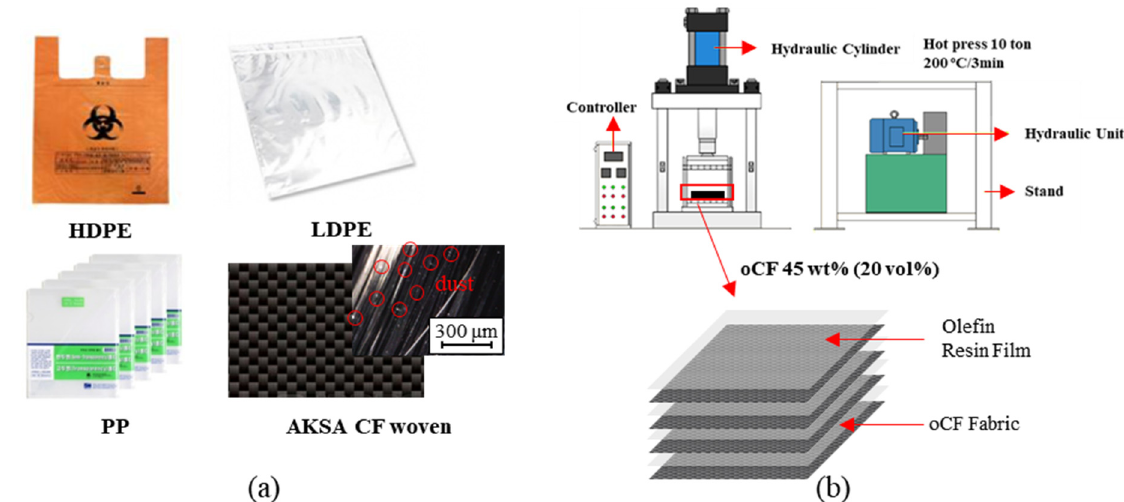
Figure 1. Experimental materials of ( a ) film-type olefin resins (HDPE, LDPE, and PP), outdated carbon fiber (oCF), and ( b ) schematics on the fabrication of outdated-waste-carbon-fiber-reinforced olefin composites (oCFOCs) by the compressive molding machine.